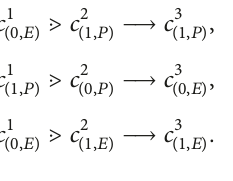
i.e., a new tree with root 𝑡 2 , so we write 𝑐 3 as 𝑐 3 (1,𝑆) . Then we denote it as the